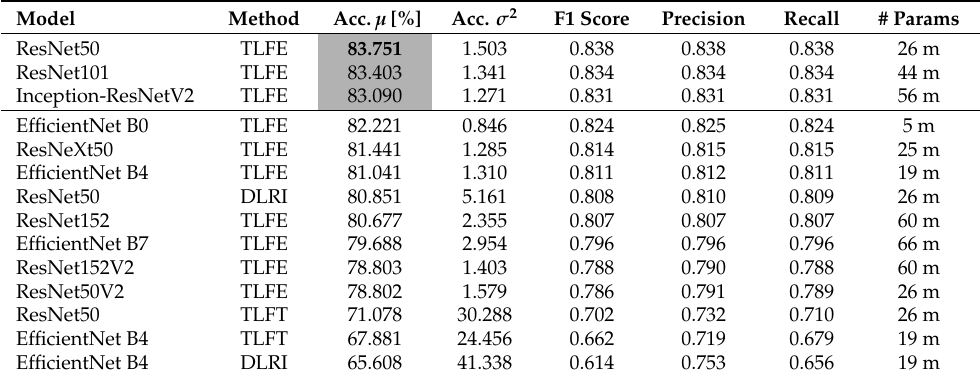
Table 2. Performance of the deep learning and transfer learning single models applied with the corresponding number of